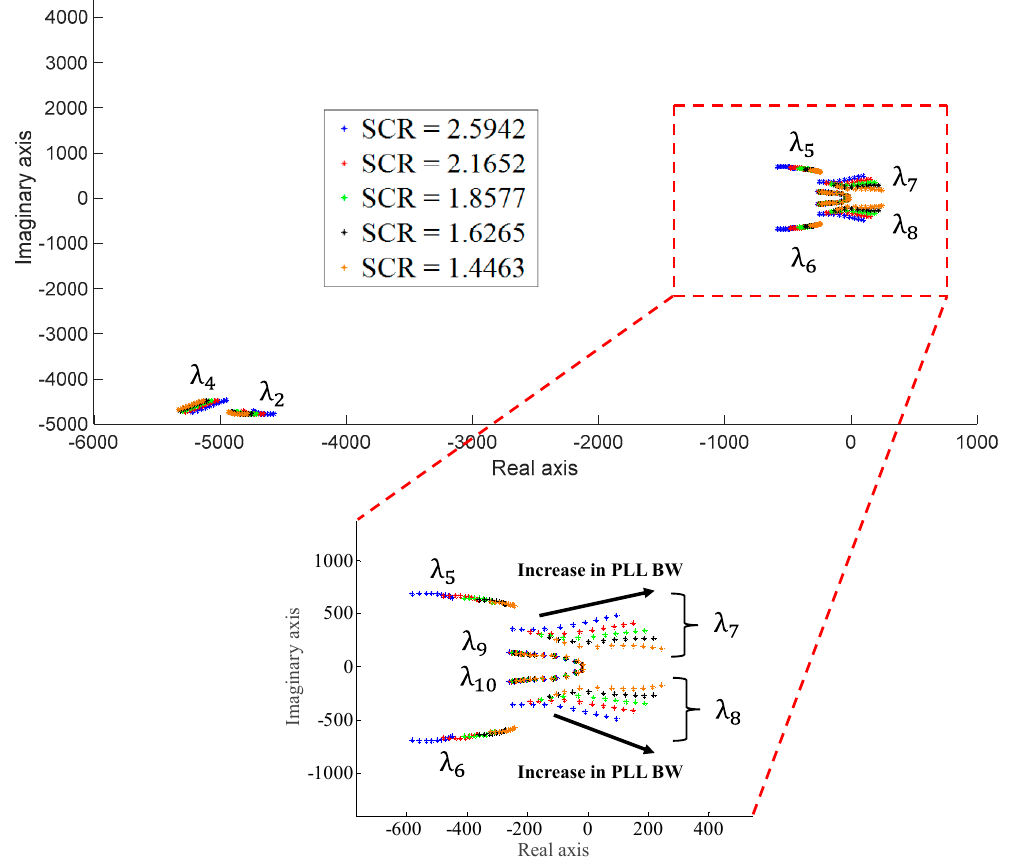
Figure 6. Eigenvalues of the proposed small signal model as a function of PLL bandwidths and SCRs.